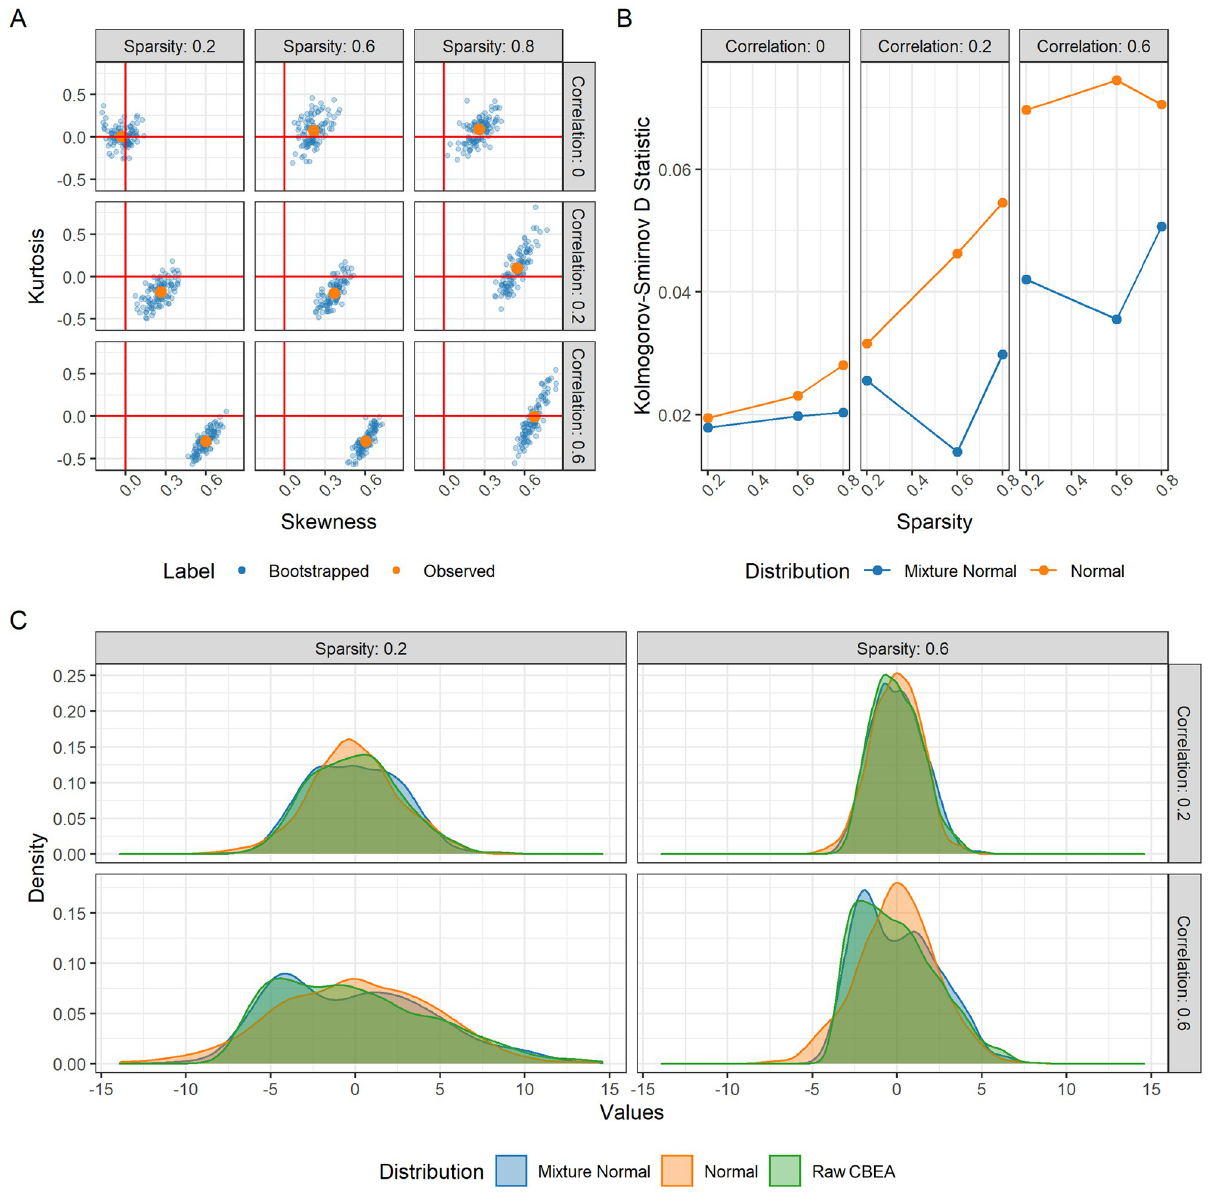
Fig 1. Properties of the null distribution of CBEA under the global null simulations. Panel (B) presents kurtosis and skewness of CBEA scores while panel (A) presents the goodness of fit (as Kolmogorov-Smirnov D statistic) for mixture normal and normal distributions. Panel (C) is a density plot of the shape of the null distribution. Results indicated the necessity of estimating an empirical null and demonstrating that the mixture distribution was the better fit compared to the basic normal.